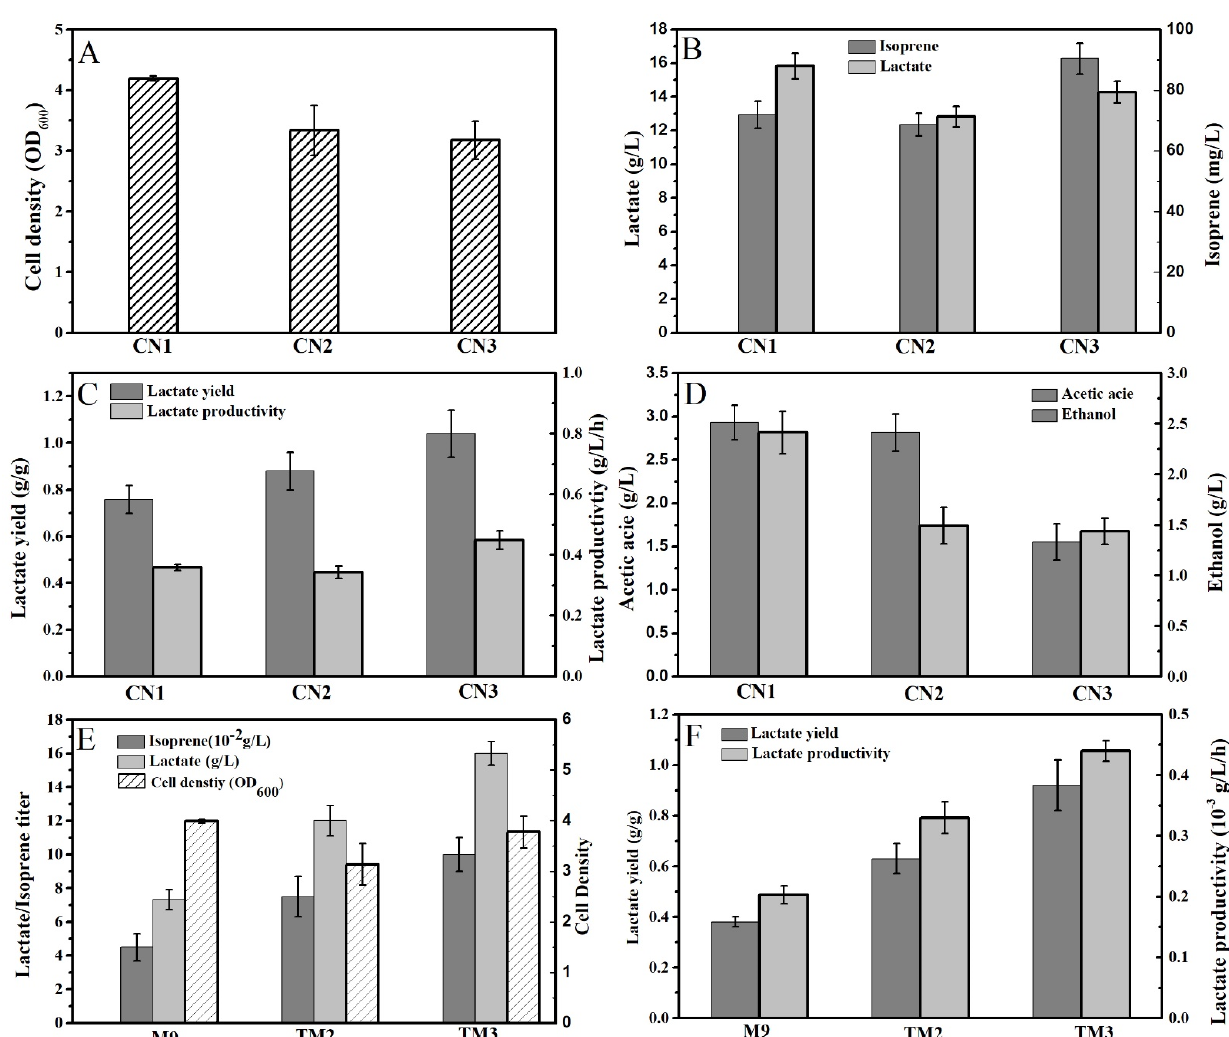
Figure 3. ( A – D ) Comparison of the levels of isoprene, lactate, acetic acid, and ethanol in flask fermentation by E. coli CN1, CN2, and CN3. ( E , F ) Levels of isoprene and lactate in flask fermentation by E. coli CN3 in different media are compared. ( A ) Cell density after 48 h of fermentation in M9 medium; ( B ) lactate and isoprene titers after 48 h of fermentation in M9 medium; ( C ) lactate yield and productivity after 48 h of fermentation in M9 medium; ( D ) acetate and ethanol titers after 48 h of fermentation in M9 medium; ( E ) the titers of isoprene and lactate after 40 h of fermentation in different media by CN3; ( F ) lactate yield and productivity after 40 h of fermentation in different media by CN3. The data shown are means of three parallel replicates, and the error bars present their standard deviation.